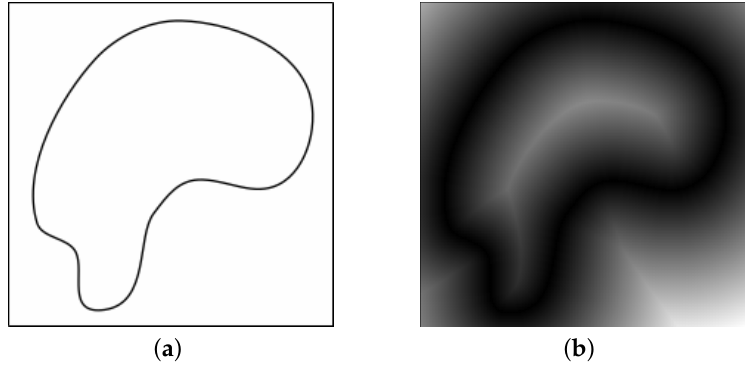
Figure 2. ( a ) The binary image before applying DT. ( b ) The result of applying DT to the binary